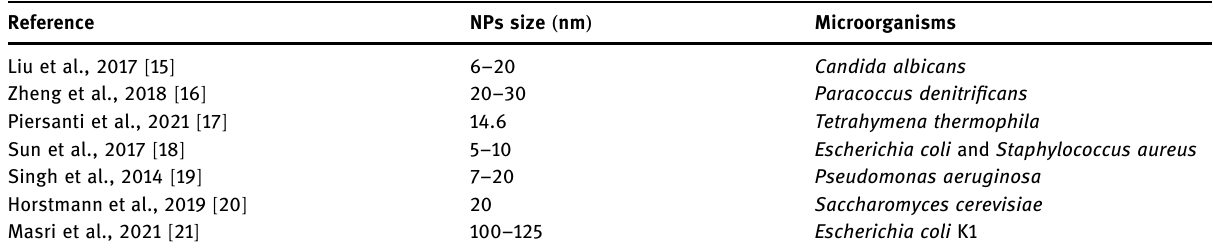
Table 1: Investigations that studied the impact of AgNPs against di ff erent microorganisms through transcriptomic pro fi ling